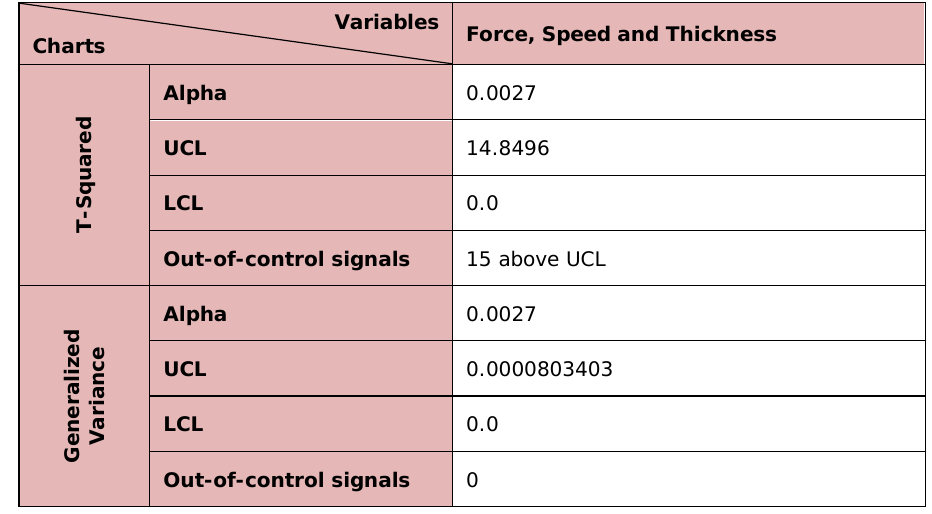
Table 8. “T 2 and generalized variance charts parameters for primary